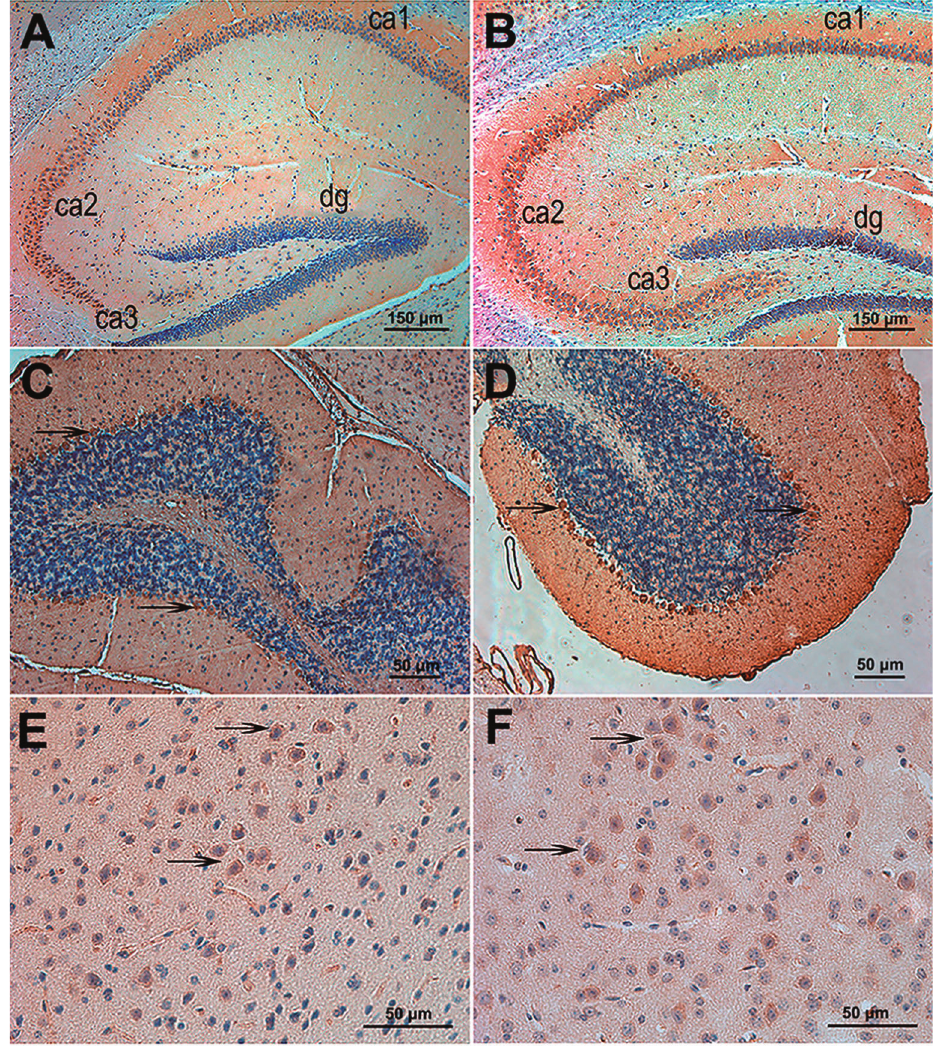
Figure 2. Immunohistochemistry of mouse Down syndrome cell adhesion molecule (DSCAM) in sagittal brain sections from 3-month-old mice. DSCAM is expressed in the hippocampus of ( A ) wild-type (WT) and ( B ) amyloid precursor protein (APP) transgenic mice. ca1, ca2, ca3: CA1, CA2 and CA3 regions of Ammon ’ s horn; dg: dentate gyrus. DSCAM expression in cerebellar Purkinje cell layers of ( C ) WT and ( D ) APP transgenic mice (indicated by arrows). DSCAM expression in middle-layer pyramidal neurons (arrows) of cerebral cortex of ( E ) WT and ( F ) APP transgenic mice. Brown staining is DSCAM; blue staining is